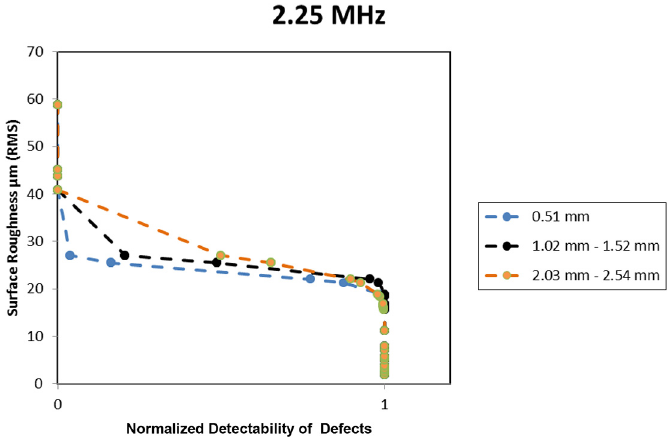
Figure 6. Defects detected